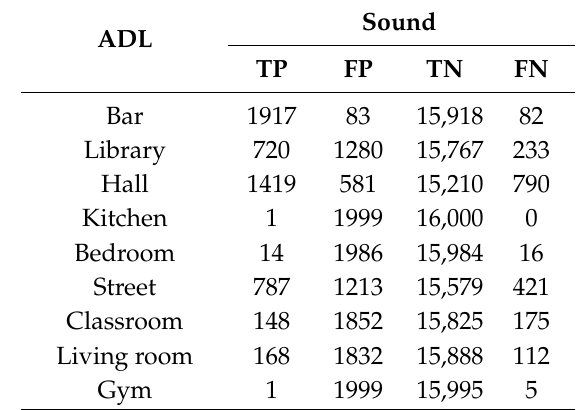
Table 11. Confusion matrix values of the recognition of environments using AdaBoost with the decision tree implemented with the SMILE framework (TP = True Positive; TN = True Negative; FP = False Positive; FN = False Negative).